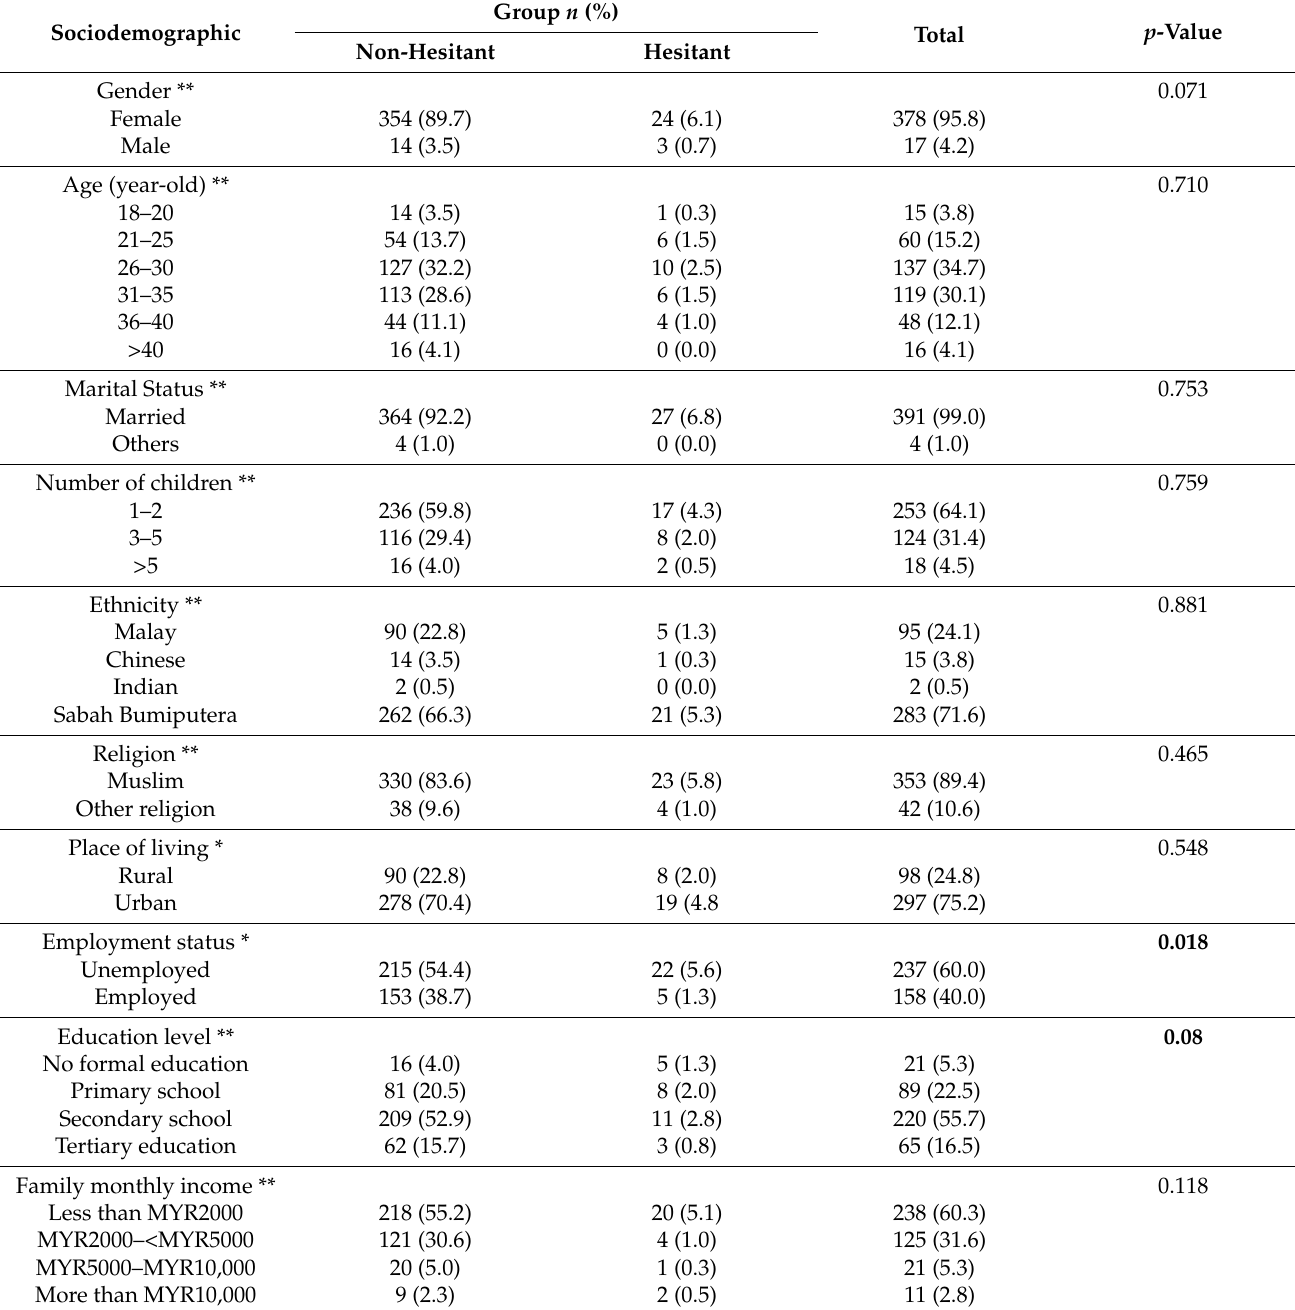
Table 2. Association between Parents’ Sociodemographic Characteristics and vaccine